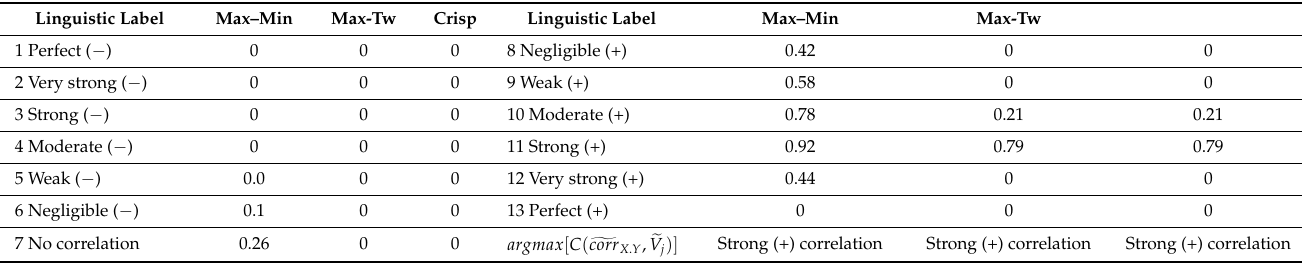
Table 8. Qualitative interpretation of max-min, max- Tw-conorm and crisp correlation between SER and relative reduction of poverty in EU 28 countries within the period 2014–2018 by using C ( (cid:103) corr X . Y , (cid:101) V k )